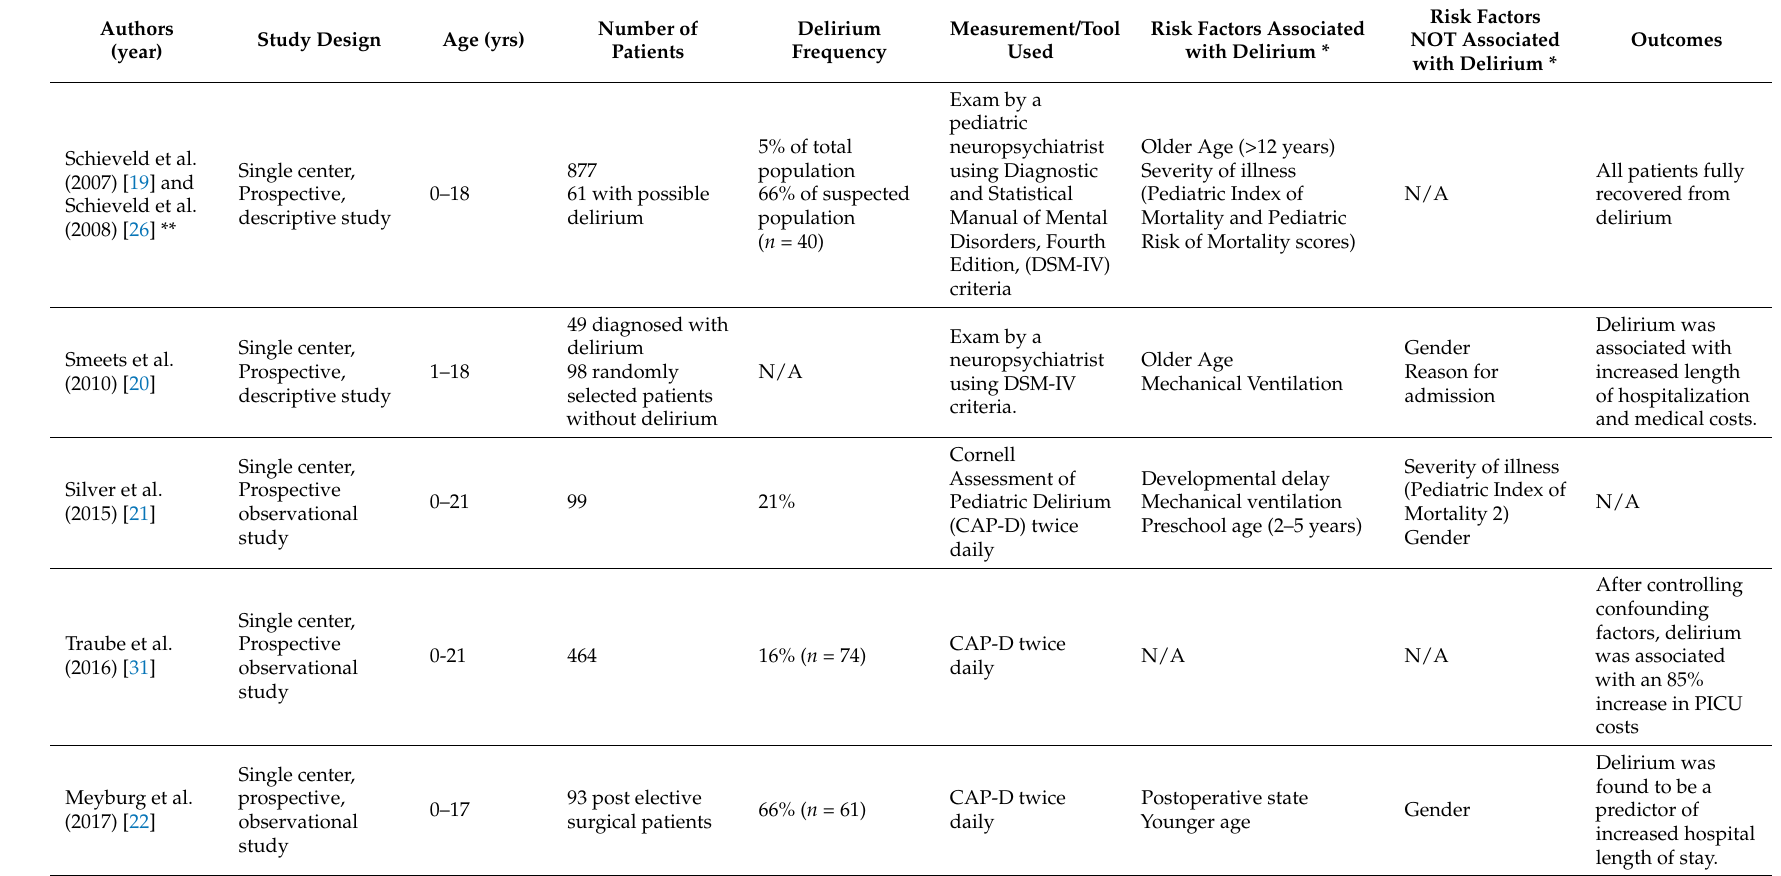
Table 2. Delirium in Pediatric Intensive Care Unit